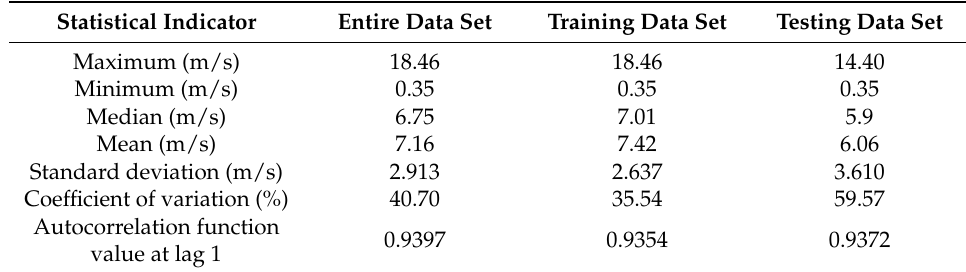
Table 6. Multi-step forecasting results of models in Sotavento Galicia wind farm.